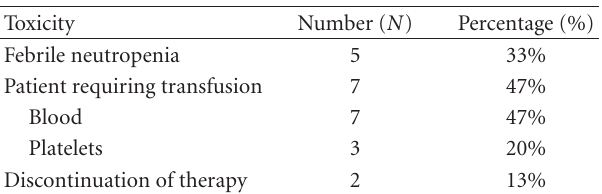
Table 3: Toxicity related to topotecan/cyclophosphamide chemo-